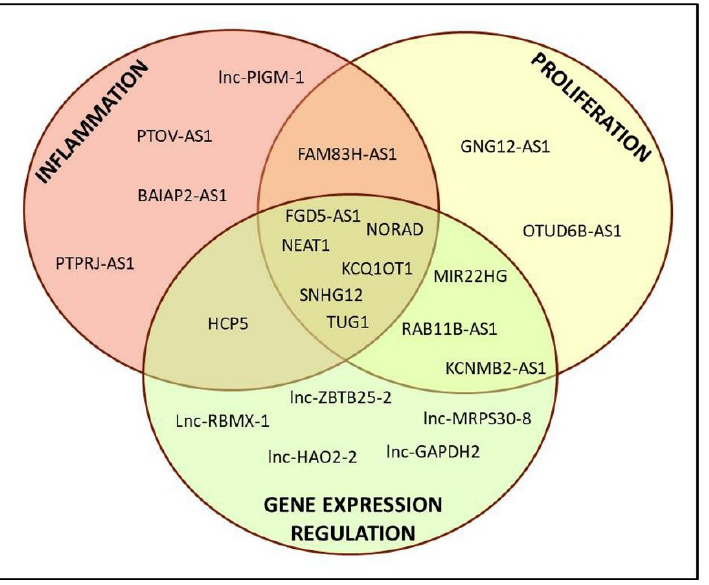
Figure 2. Representative scheme of the derived classification of the 22 lncRNAs with known function.